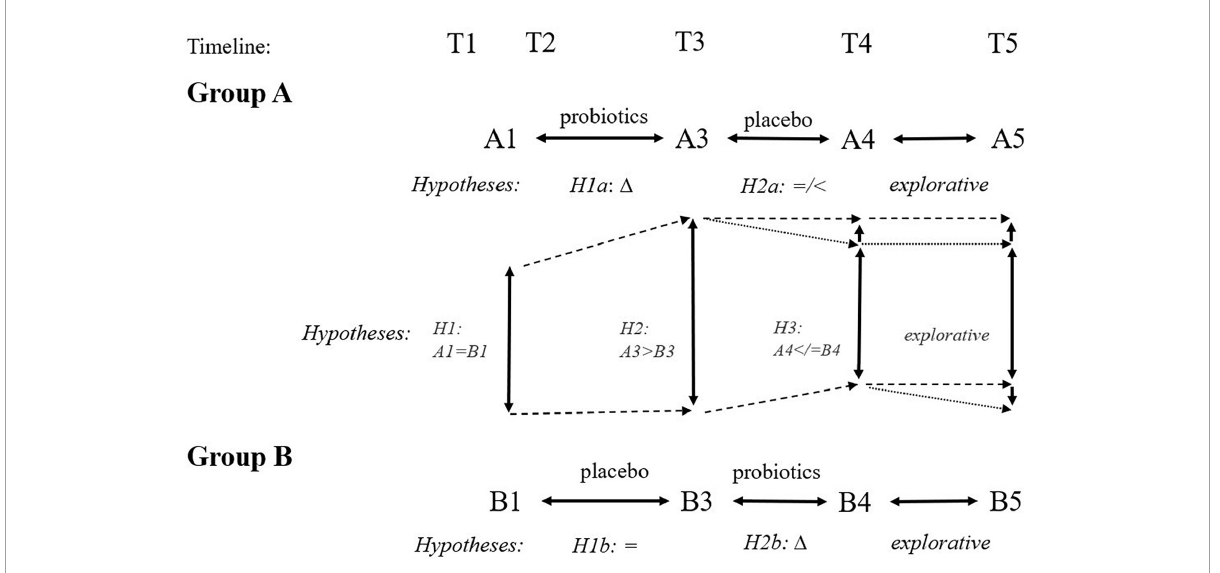
FIGURE4 Expected hypotheses of cross-sectional (inter-group) and longitudinal (intra-group) comparisons at different time points. We expect improvement following the 3-month administration of probiotics ( (cid:49) : H1a, H2b, H2, H3). We expect no favorable change following the 3-month administration of placebo (H1b: =, H2a: =/<). Finally, we expect group B ending with the probiotic arm will have better outcomes than group A ending with placebo arm at time point T5 because of different intervals from the probiotic use (6 months for group A and 3 months for group